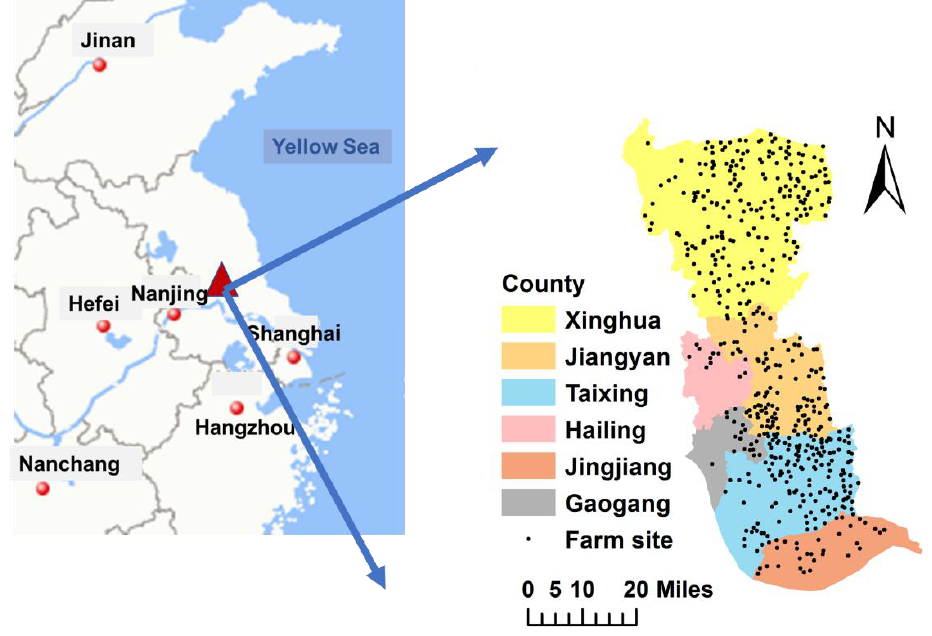
Figure 1. Geographical location of the study area and distribution of breeding farms.